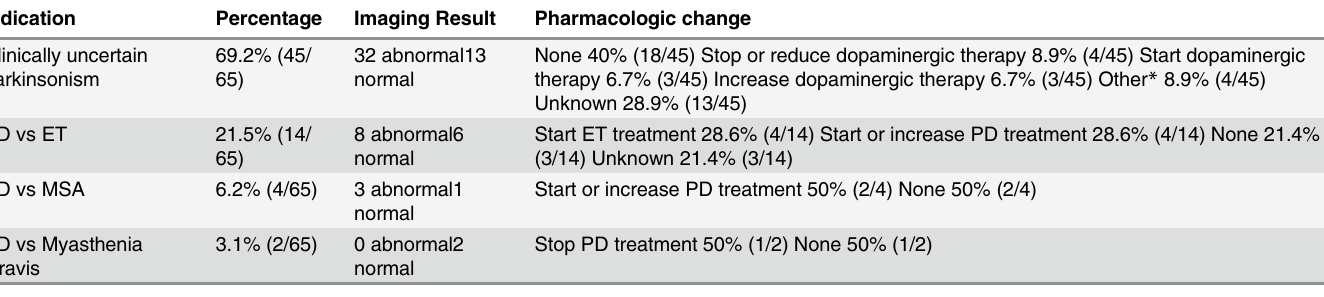
Table 2. Changes in therapy by indication and result of dopamine transporter